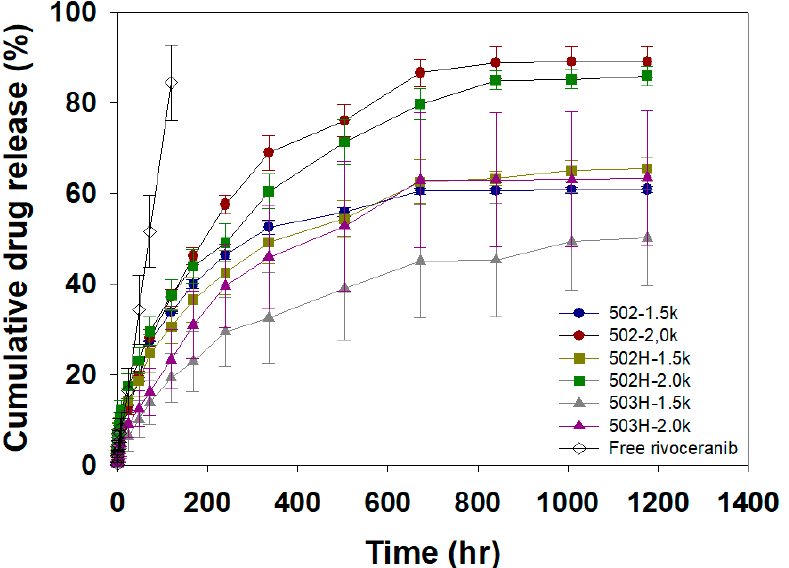
Figure 5. In vitro release curves of free rivoceranib and rivoceranib-loaded microspheres. The drug release profiles were represented as a mean ± SEM ( n = 3).